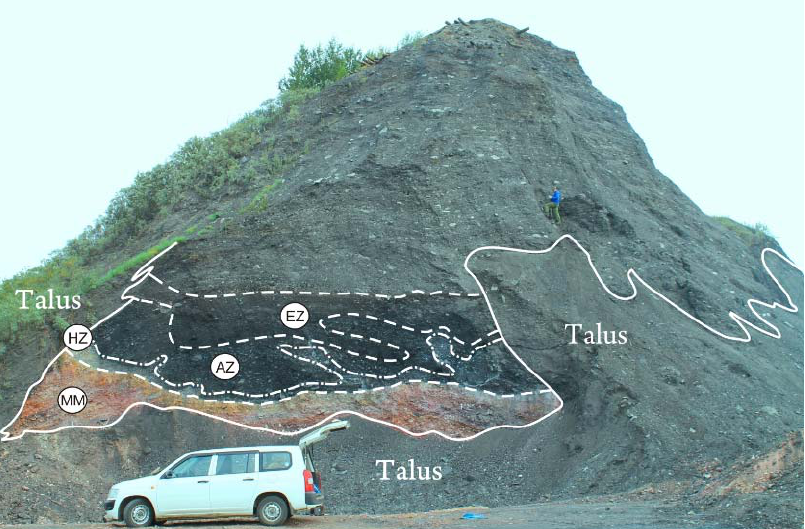
Figure 2. Type section of quiet spoil heap Ch-09 in Cheremhovo. The red rocks of metamorphic massif (MM) are deposited in the basement. On the metamorphic massif, the “Black block” of pyrolysis rocks is superposed, within which the following zoning is delineated: EZ–enriched zone; AZ–activated zone; HZ–heat zone. The “Black block” is overlapped by sandy and clay deposits with debris of fine and medium sandstones.